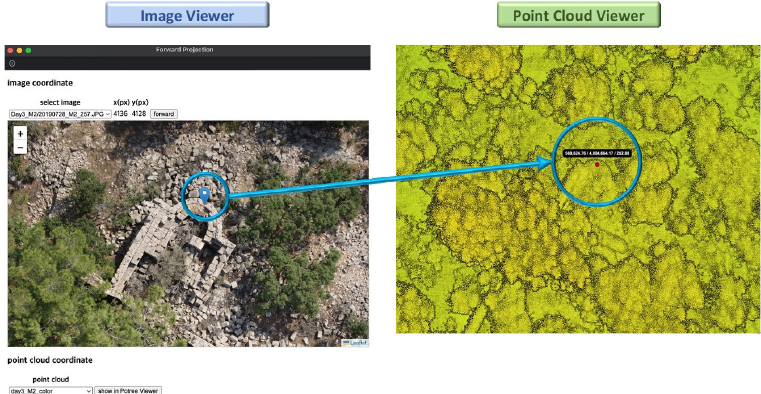
Figure 21. Illustration of the forward projection of a selected point (blue placemark) in an image and the corresponding point in LiDAR data (red dot).